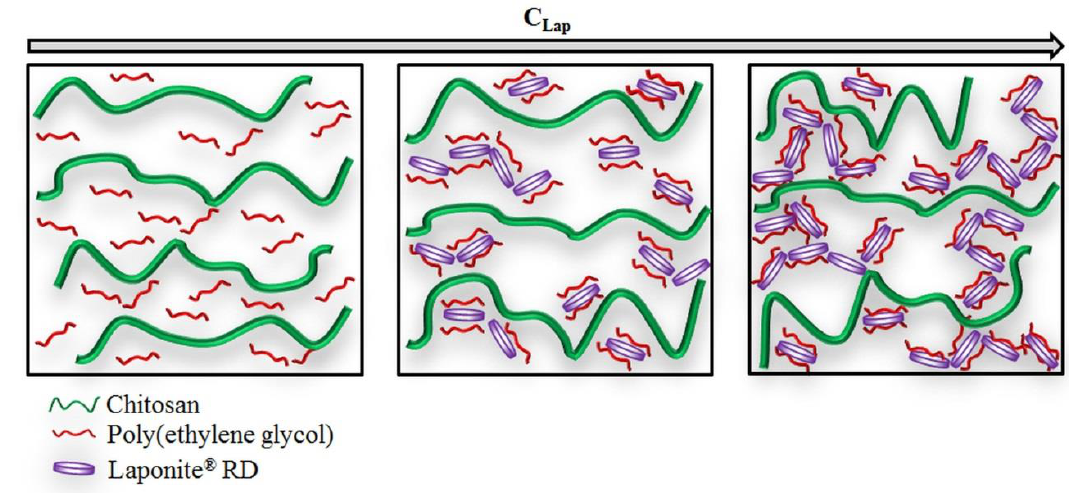
Figure 8. Schematic representation of film structures with various clay concentrations.